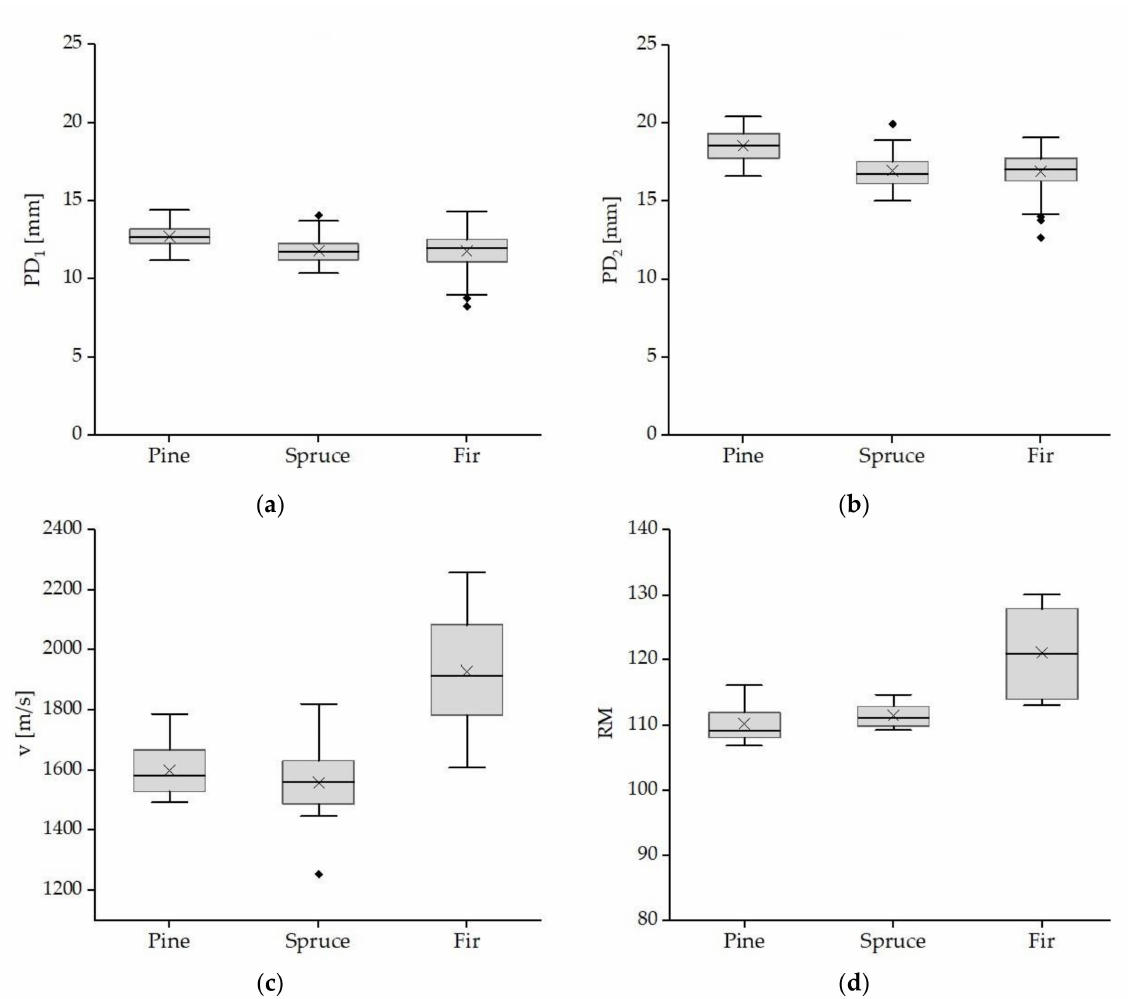
Figure 9. Distribution of test properties in the reference sample for individual wood species. Penetration depth ( a ) after a single impact, ( b ) after a double impact; ( c ) velocity of ultrasonic wave propagation; ( d ) drilling